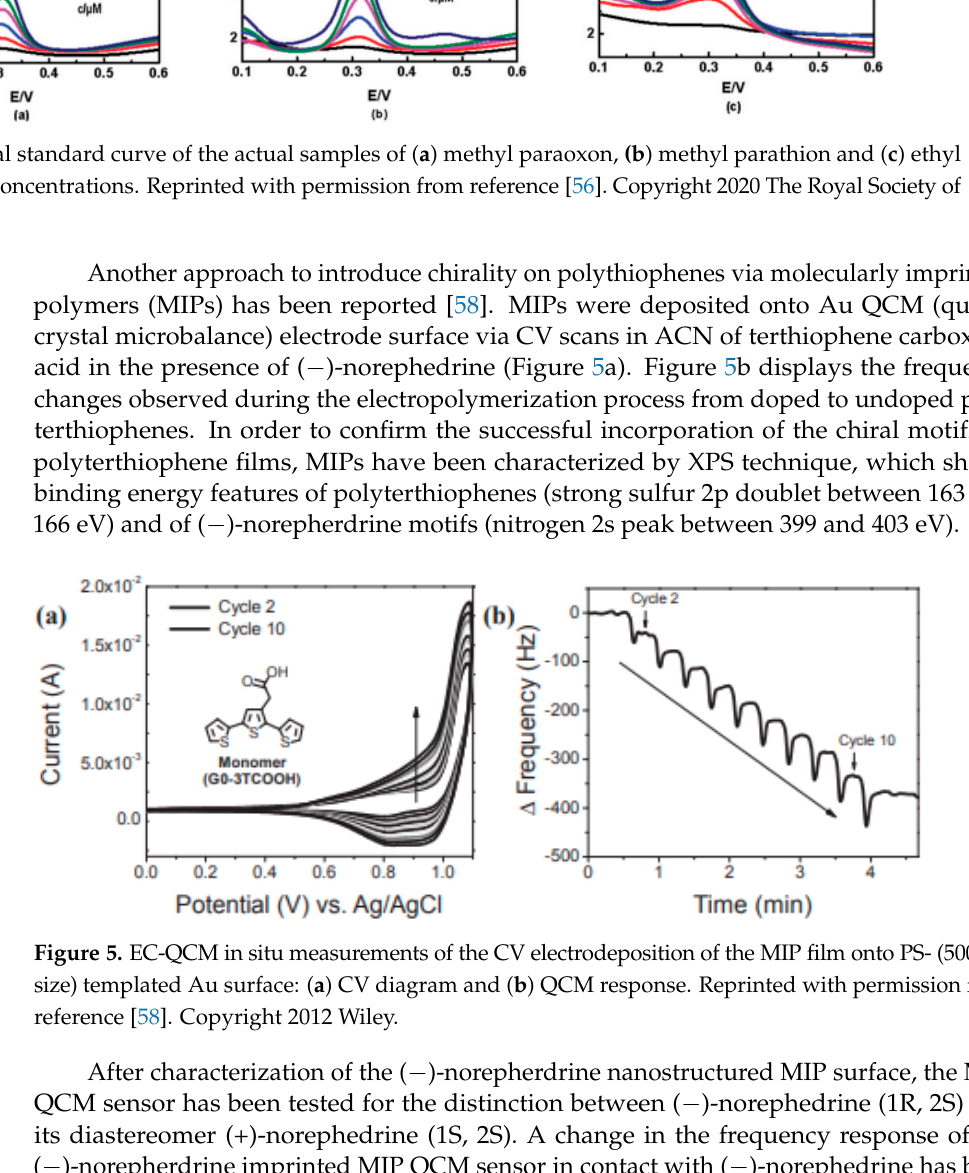
Figure 4. Electrochemical standard curve of the actual samples of ( a ) methyl paraoxon, (b ) methyl parathion and ( c ) ethyl paraoxon with varying concentrations. Reprinted with permission from reference [56]. Copyright 2020 The Royal Society of Chemistry.